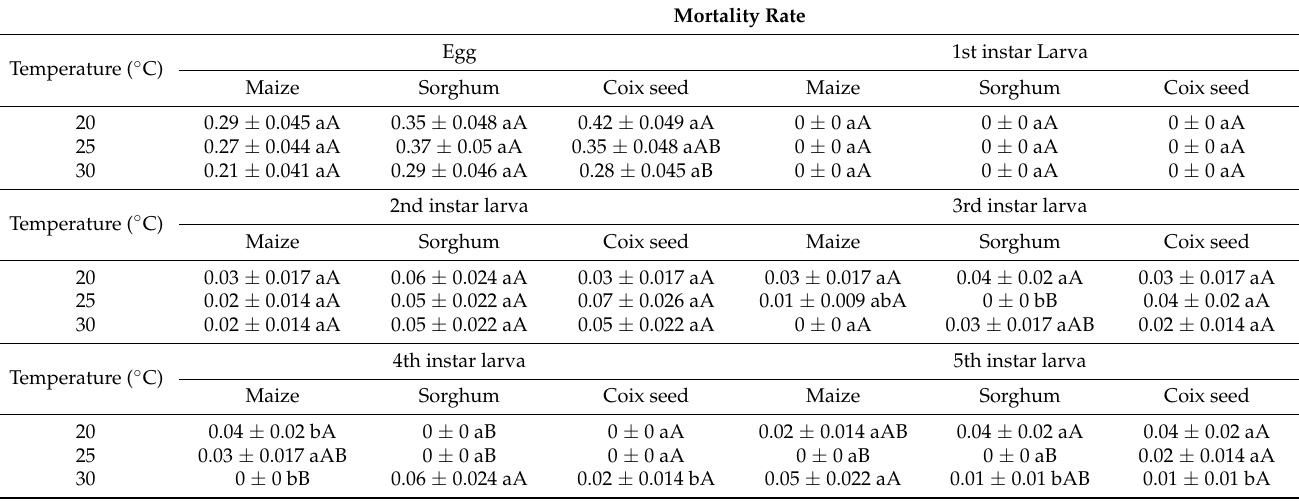
Table 1. Mortality of mean ( ± SE) different developmental stages of Spodoptera frugiperda reared on different host plants at different temperatures